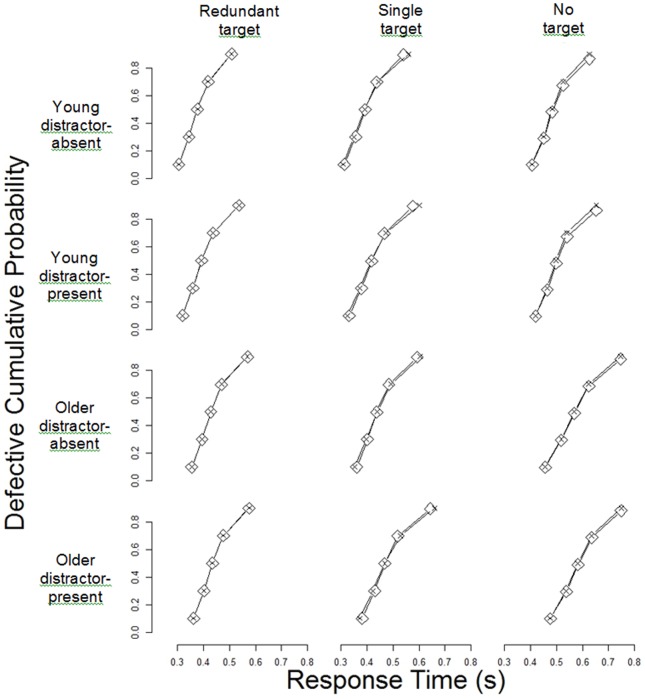
Cumulative Distribution Functions for correct responses from redundant-, single- and no-target trials, averaged over younger and older participants in distractor-present and distractor-absent tasks.Observed data are plotted using diamonds and model predictions using crosses.